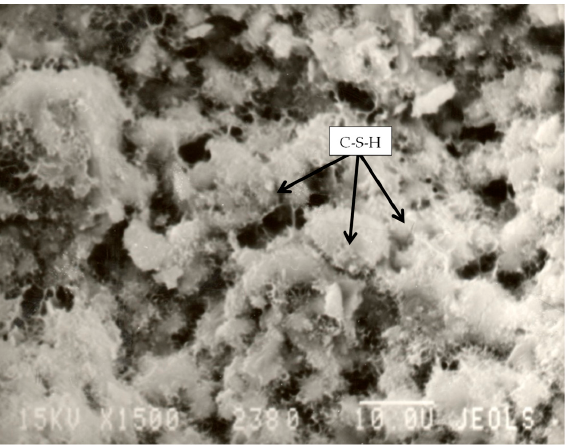
Figure 25. The structure of SPC-based stone with stabilized slag suspension at 2 days age (electron microscopy, ×3000). Such crystallohydrates are involved in the construction of cement matrix, which, due to prolonged hydration, is compacted and strengthened, thereby contributing to an increase in strength characteristics of the stone. The results of this work show that the introduction of stabilized GGBS suspensions contributes to an increase in the initial and 28-day strength of OPC- and SPC-based samples, which allows for the use of this type of cement without heat and moisture treatment in multi-storey building construction. The studies show that when ultra fi ne admixture is introduced into the composition of a cement-sand mortar, the structure of the cement stone becomes denser. This leads to an increase in the sulfate a tt ack resistance of the material in a sulphate medium. Increased density and sulfate a tt ack resistance of the obtained composites demon- strate that concrete based on this material can be used as a protective layer of steel rein- forcement. It is assumed that the ultra fi ne component in the protective layer of concrete provides dense structure of the cement stone which can prevent concrete cover separa- tion under aggressive external medium and increase its durability. 5. Conclusions The authors considered the possibility of introducing GGBS into the cement system in the form of a stabilized slag suspension instead of mixing water. This method provides uniform distribution of the additive in the matrix of the material and contributes to im- proving technical characteristics of the fi nal product. To investigate the increased characteristics of cement stone modi fi ed with ultra fi ne additive, a number of studies on homogenization and stabilization of fi ne slag suspen- sion were conducted. The authors established optimal parameters for ultrasonic processing at UZDN-I device to achieve uniform distribution of fi ne slag additive in the suspension: the pro- cessing time is 15–20 min, the frequency of ultrasonic vibrations is 44 kHz, the tempera- ture of the dispersed medium is 25 ± 2 °C.